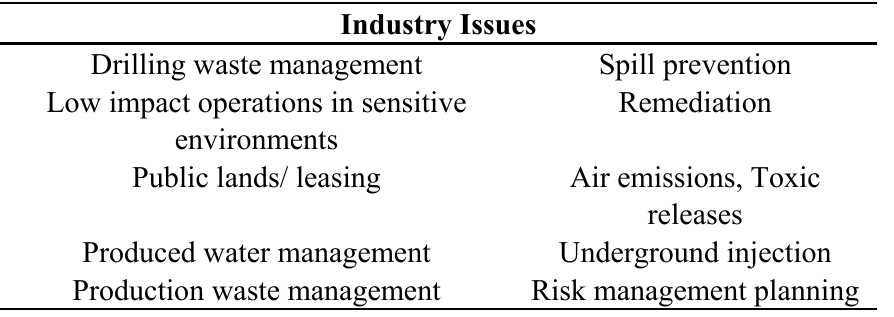
Table 1. Common Environmental Problems of the Oil